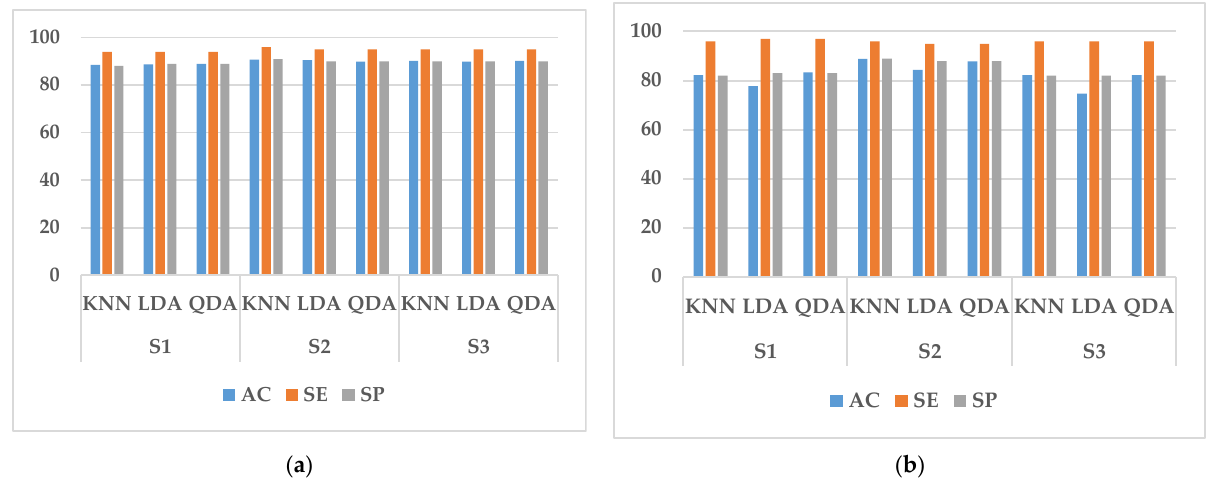
Figure 7. Random cross-validation of EMG data. ( a ) Vehicle driving experiment; ( b ) Simulated driving experiment.